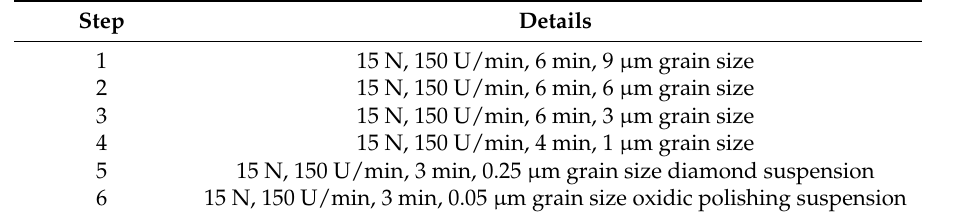
Table A7. Polishing steps. Table A8. Influence of grinding and polishing steps on the example of DP600.